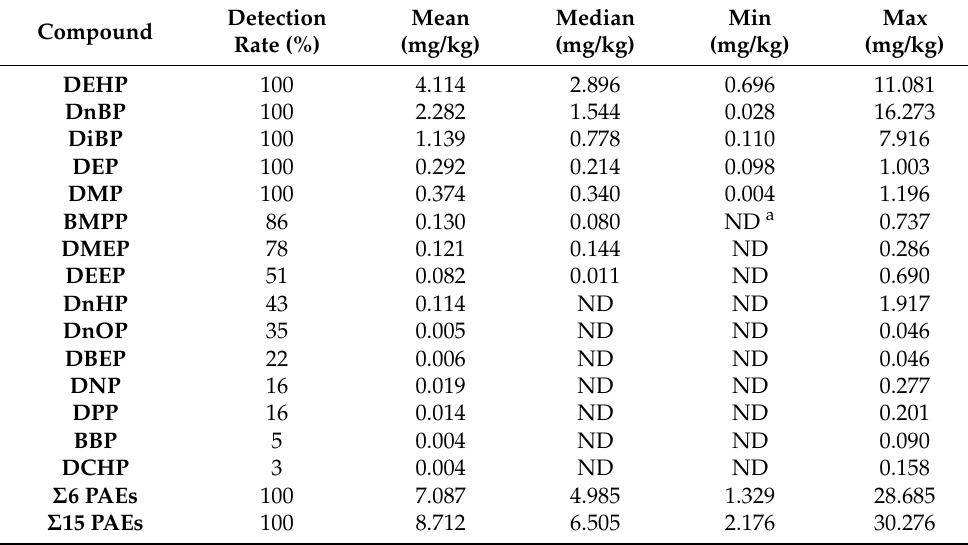
Table 3. Concentrations of Σ 15 PAEs in plant samples in coastal areas of South China. Detection Mean Compound Rate (%)